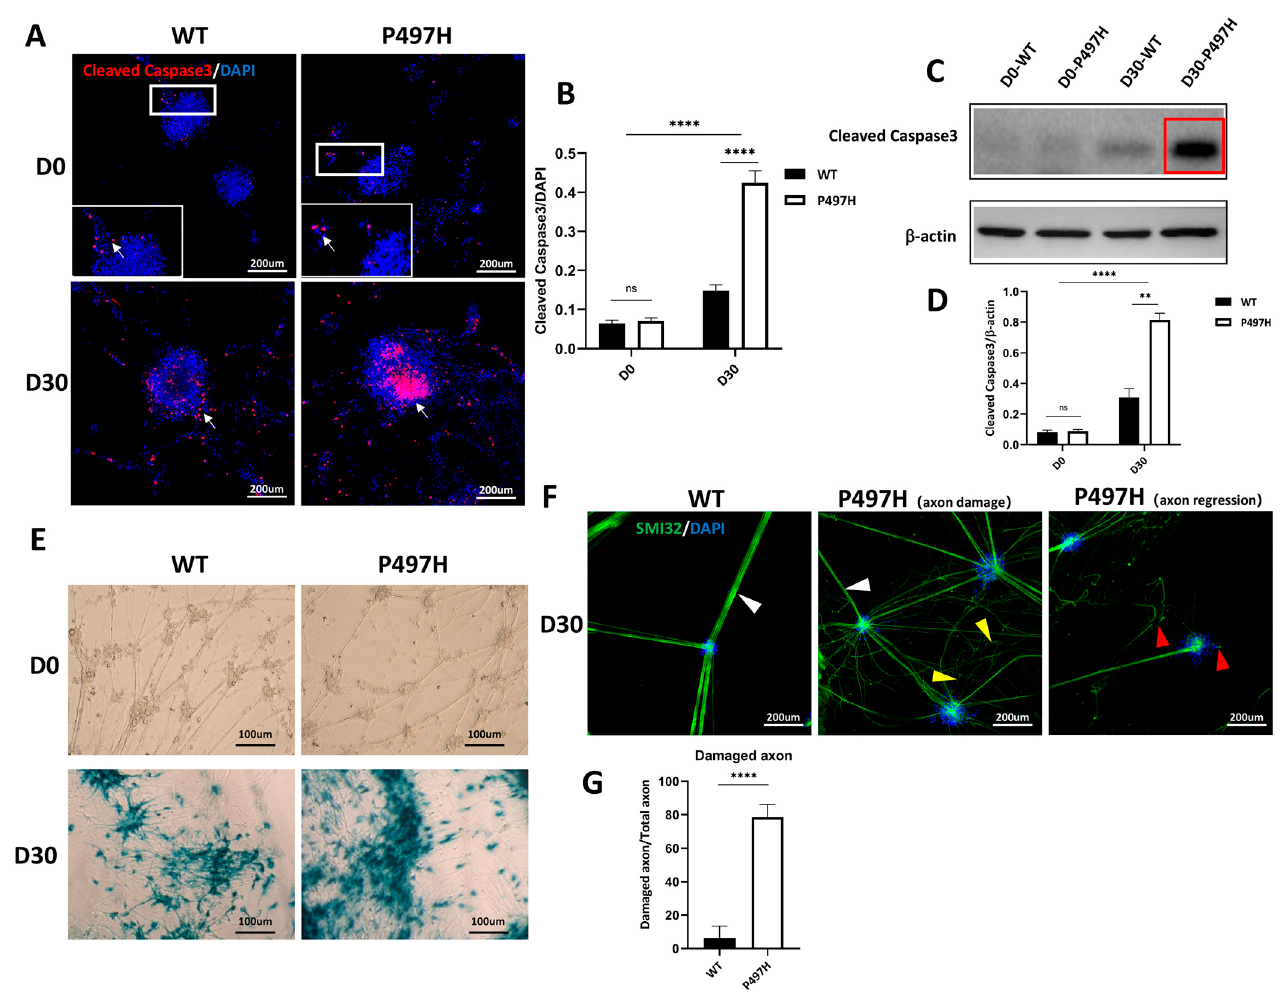
Figure 3. IPSC-derived MNs display apoptosis and axonopathy. ( A ) Immunofluorescence of cleaved caspase3 in WT and UBQLN2 iPSC-MNs at D0 and D30, used to evaluate apoptosis. White boxes indicate enlarged area in inset, and white arrows indicate cleaved caspase3. ( B ) Quantification of ( A ). ( C ) Western blot analysis of cleaved caspase3 in WT and UBQLN2 P497H MNs at D0 and D30. ( D ) Quantification of ( C ). ( E ) b-galactosidase activity of WT and UBQLN2 P497H MNs from D0 to D30 during in vitro culture. ( F ) Representative immunofluorescence images of axonal morphologies of 30-day-maturated WT and UBQLN2 iPSC-MNs. The axons of UBQLN2 P497H MNs began to be damaged and tended toward axon regression (smooth: white arrow heads, damaged: yellow arrow heads, degenerated: red arrow heads). ( G ) The number of abnormal axons was evaluated in aged cultures and revealed a dramatic loss of normal smooth axons in UBQLN2 mutants (n = 30). Data information: Data are shown as mean ± SEM, n = 3 independent experiments, ns, not significant, ** p < 0.01, **** p < 0.0001.